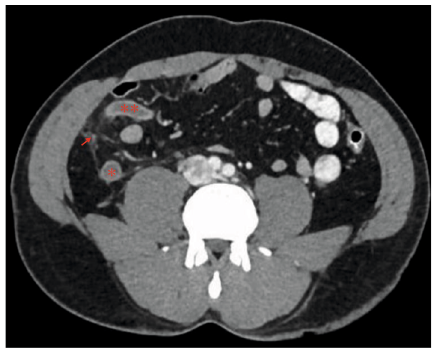
Figure 1: Abdomen CT scan with IV and oral contrast showing dilated appendicular tip ( ∗∗ ) and base ( ∗ ), with periappendiceal fat stranding (arrow) and enhancing wall.